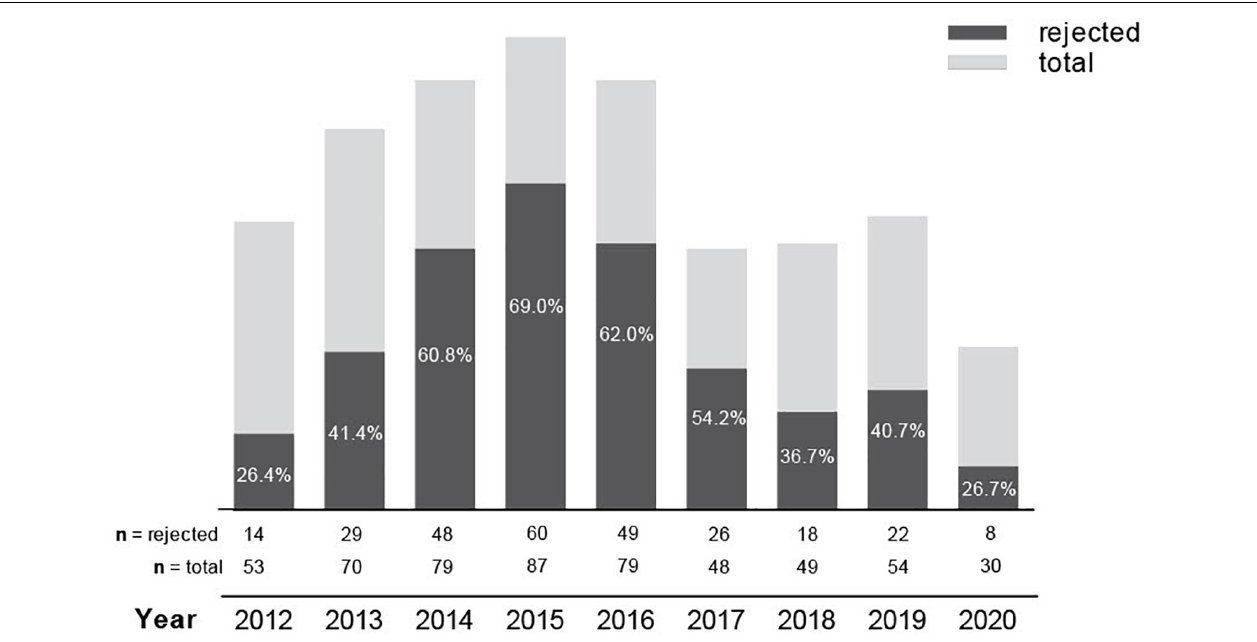
FIGURE 3 | Percentage of potential donors disqualified for LKD per year from 2012 to 2020:%, percentage; n, number.